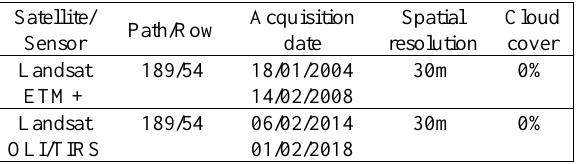
Table 1. Characteristics of satellite data